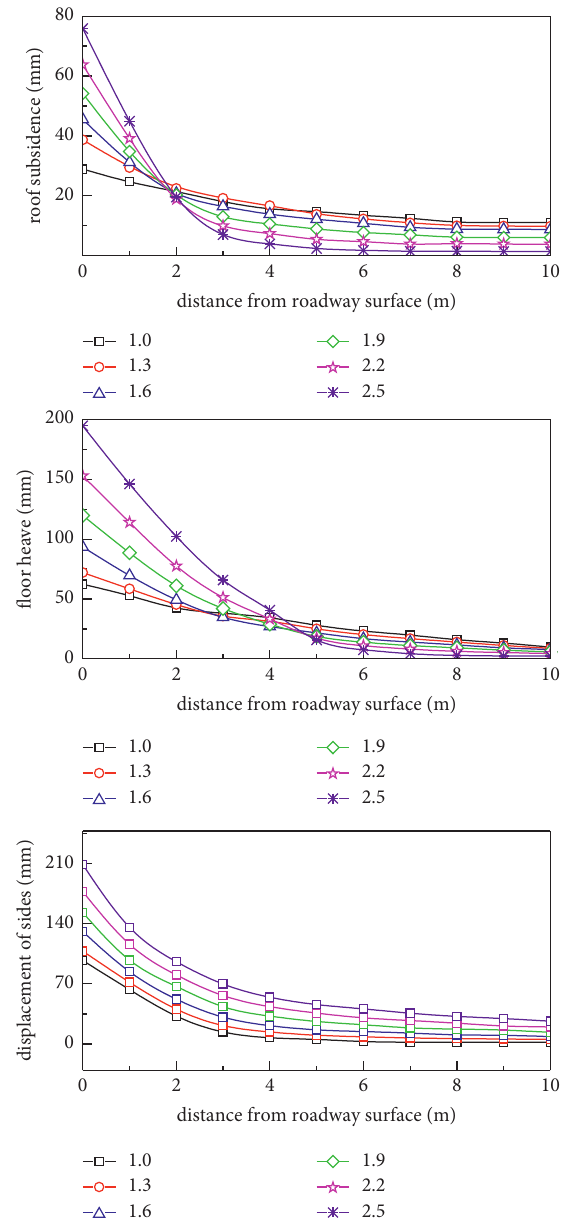
Figure 10: Deformation law of roadway surrounding